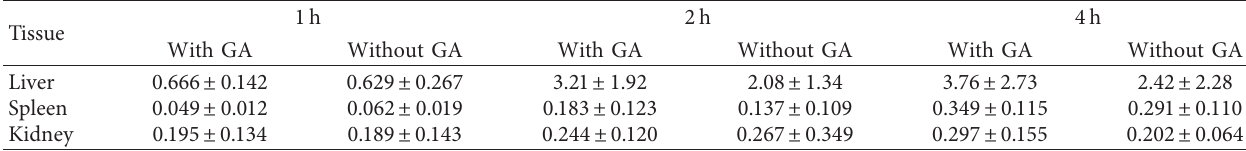
Table 4: Results of BB at a dose of 400mg/kg in tissues of rat (mean ± SD, n � 6, µ g/g).